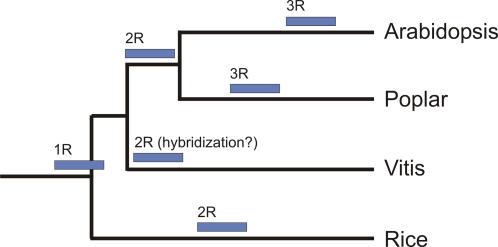
Scenario of angiosperm genome evolution.Alternative scenario to the one proposed by Jaillon et al. [7] to explain angiosperm genome evolution. Our analyses seem to suggest that there has been a large-scale duplication event, likely a hybridization event, in the Vitis lineage, rather than before the split of Vitis and other dicots. See text for details.